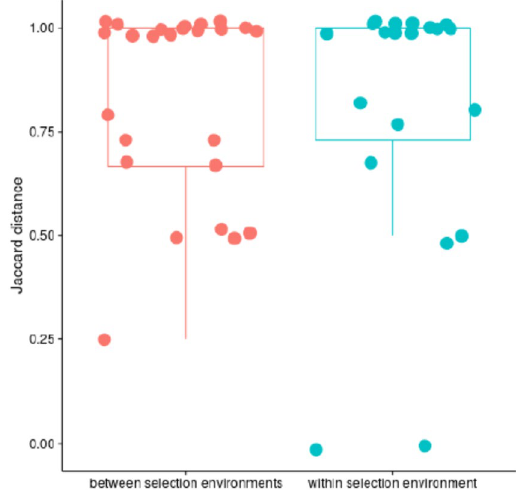
Figure 4. Parallel evolution as assessed by Jaccard Distance for operons (1 = no shared evolution) (box depicts 25–75% interquartile range, the whisker shows the largest value inside 1.5x